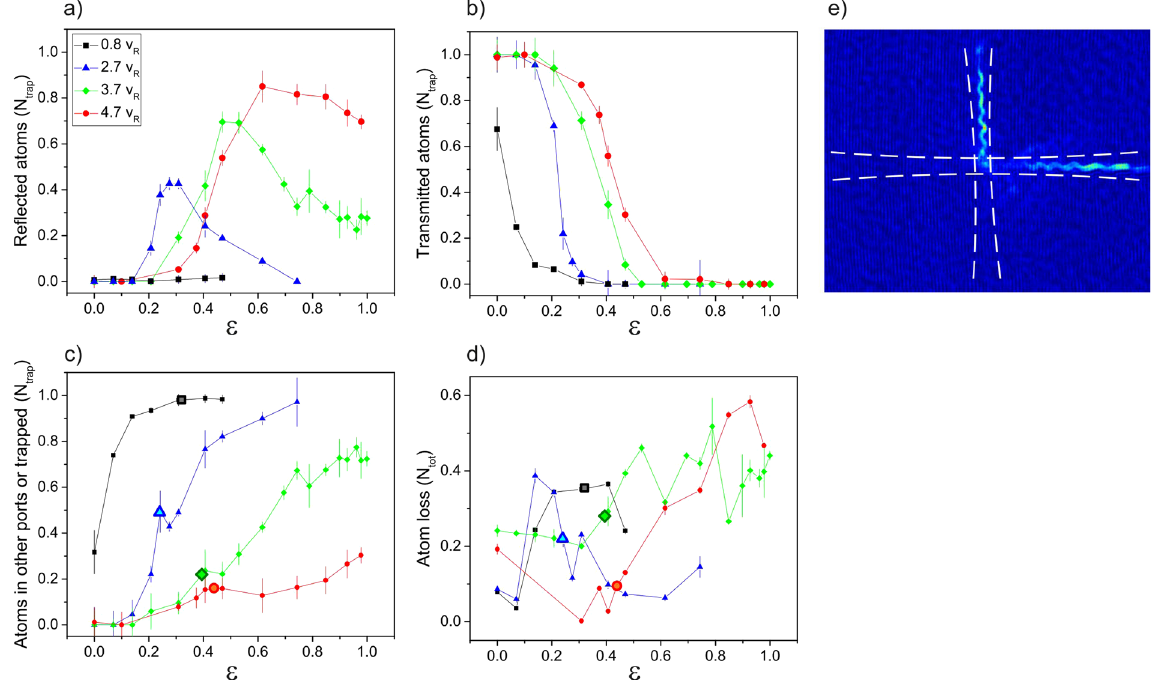
Figure 4. Number of atoms which are ( a ) reflected into WG2 along a single port, ( b ) transmitted in WG1, and ( c ) lost in the other two ports or trapped in the crossing region, as a function of the lattice height ε for four different propagation velocities. The measurements are taken roughly 20 ms after the atoms first arrived at the crossing and are normalized by the total atom number in the trap . Information on the losses from the trap following the passage through the crossing is reported in ( d ). The relative difference in the atom number measured before and after the interaction with the lattice is shown. In ( c , d ) we have highlighted with larger symbols the values which correspond to an equal splitting between the two exit ports in WG1 and WG2. Solid lines are guides for the eyes. ( e ) For v ~5v R and larger, the atomic cloud can be split into two equally populated fragments propagating along WG1 and WG2 with best efficiency around 80% (comprehensive of the losses from the trap). Note that, by tuning the lattice height in this regime, the splitter can be also used as a mirror with best efficiency larger than 60% (comprehensive of the losses from the